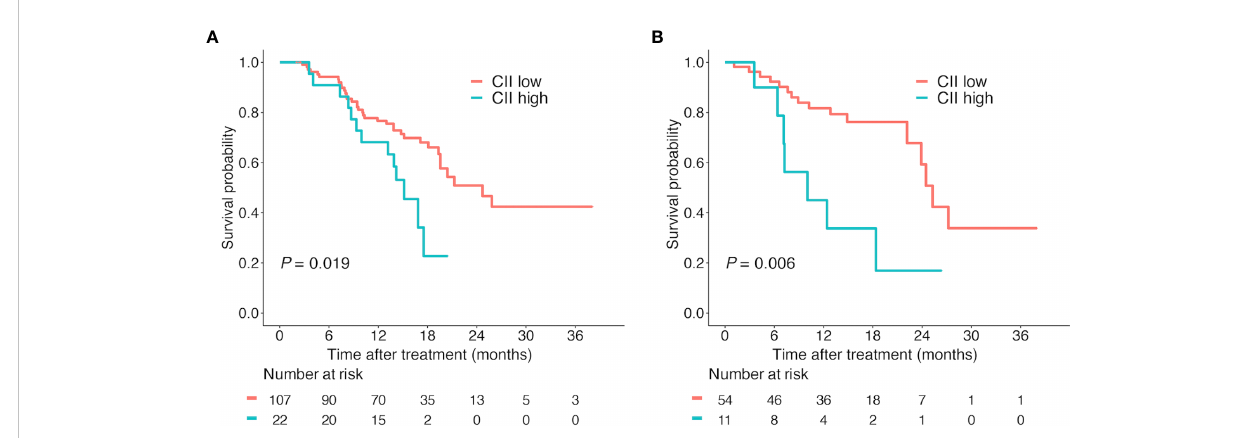
FIGURE 2 Kaplan-Meier survival curves according to CII. Overall survival according to CII (cutoff value = 43.1) in the training cohort (A) and validation cohort (B) . Abbreviations: CII, circulating immune